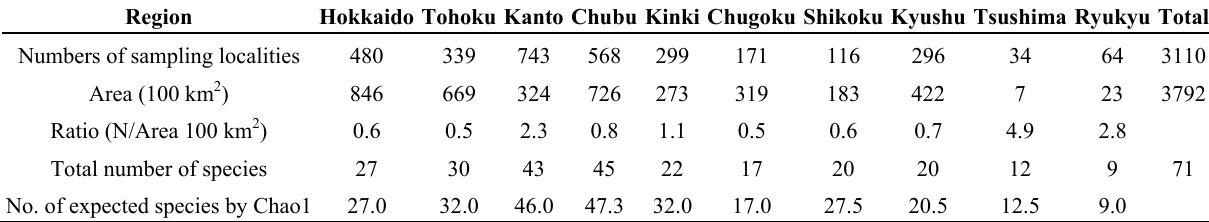
Table 1. The number of sampling localities and species richness.